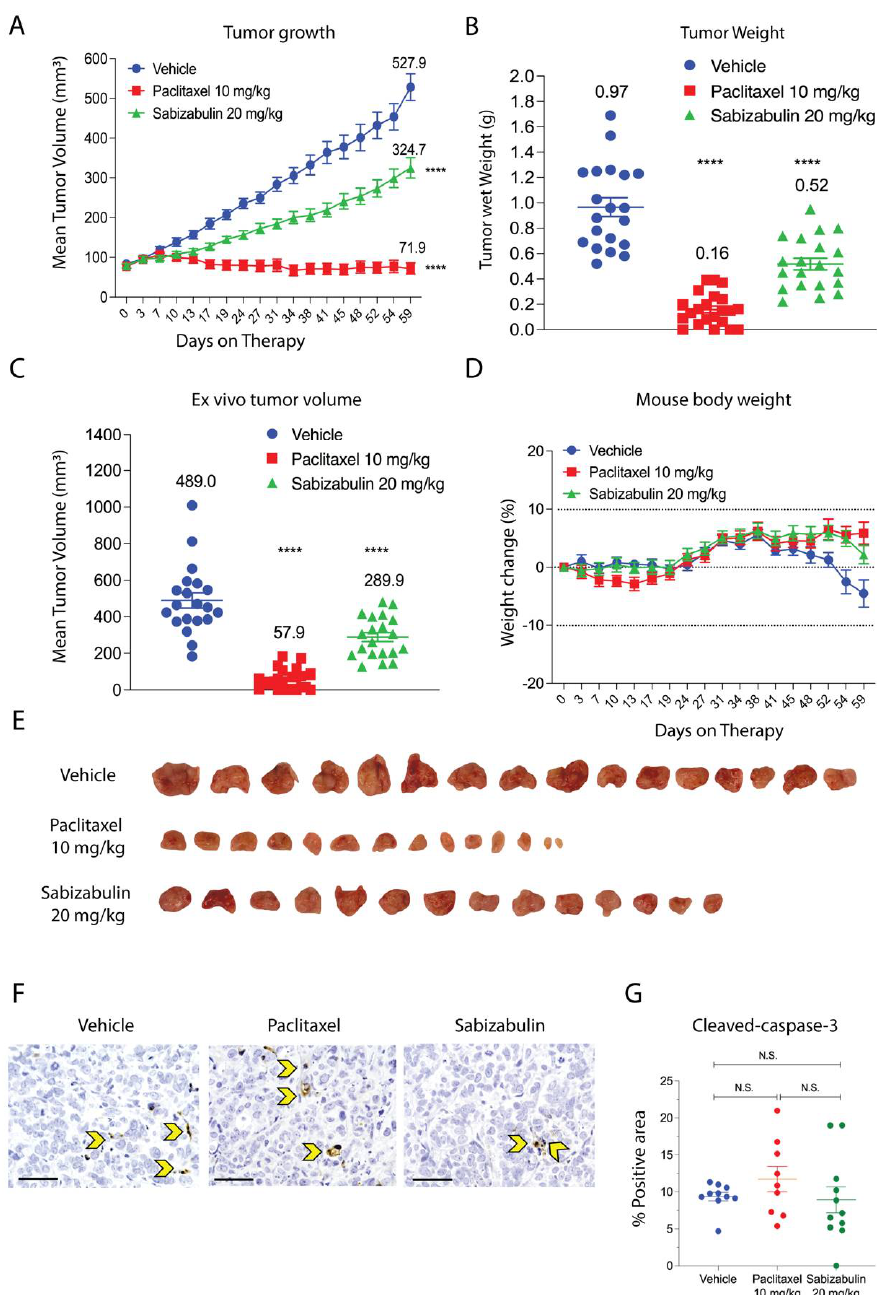
Figure 5. Sabizabulin inhibits primary tumor growth in the HCI-12 PDX model. ( A ) The mean increase in tumor volume (mm 3 ) over time on treatment (days on therapy, A ) and tumor wet weight (grams, g) ( B ) at the study endpoint of59 days after treatment with vehicle (3 × /week, IP, n = 21 total tumors), paclitaxel (10 mg/kg; 3 × /week, IP, n = 22 total tumors), or sabizabulin (20 mg/kg, 3 × /week, PO, n = 18 total tumors). ( C ) The mean ex vivo tumor volume and the percentage increase in body weight for vehicle (n = 11 mice), paclitaxel (n = 11 mice), or sabizabulin (n = 12 mice) relative to body weight at the start of therapy ( D ); the dashed lines indicate initial body weight (y = 0) with a − 10% to +10 % variance over time (days on therapy)( A – C ) All pairwise comparisons were made to the vehicle control; **** p < 0.001. ( E ) Representative images of resected tumors. ( F ) Representative images of IHC slides stained with cleaved caspase-3 (600 × magnification; scale bar 50 µ M); yellow arrowheads indicate example apoptotic cells. ( G ) Scatter plot of % positive area for cleaved-caspase-3. N.S. = not